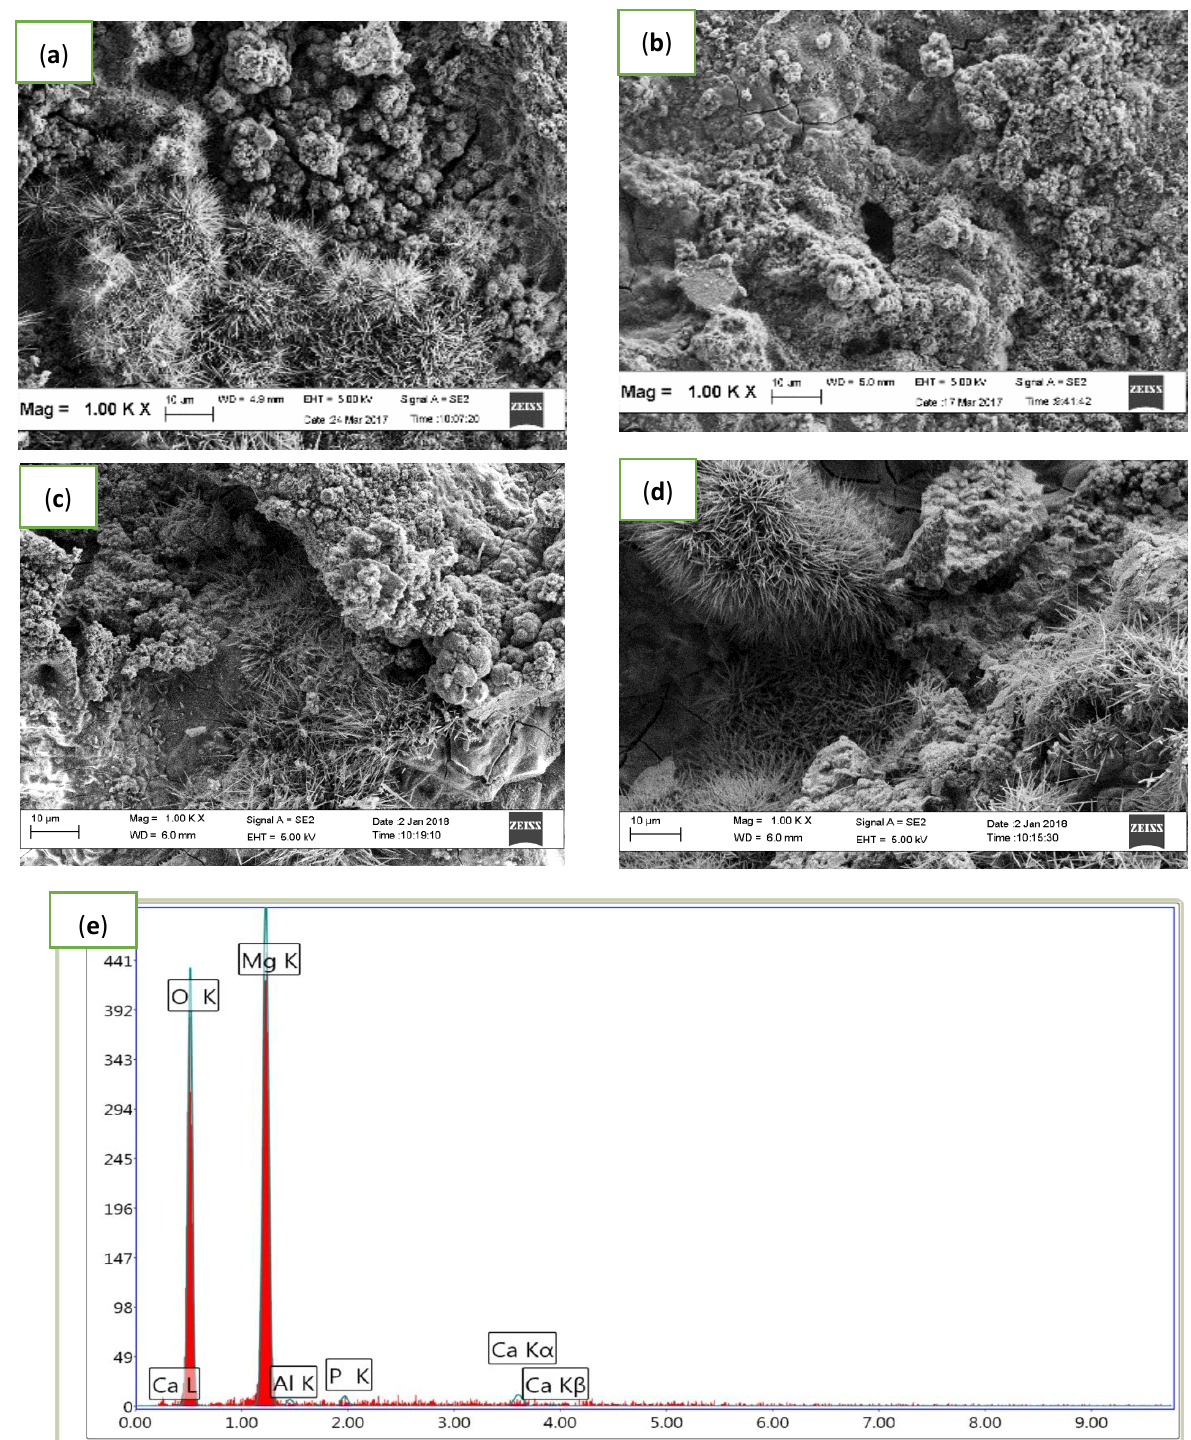
Figure 10. Microstructure of Mg-Zn/HAP Al 2 O 3 after an immersion test for 2 h in HBSS ( a ) 0 wt.% ( b ) 5 wt.% ( c ) 10 wt.% and ( d ) 15 wt.% Al 2 O 3 with (e) EDX analysis for 10 wt.% Al 2 O 3